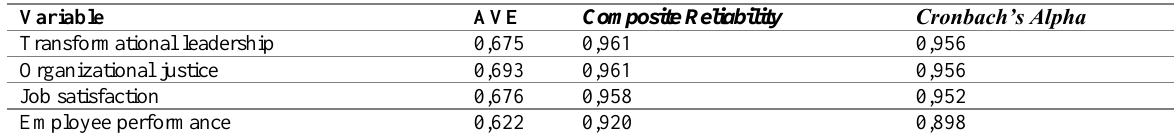
Table 3: AVE, Composite Reliability , and Cronbach’s Alpha